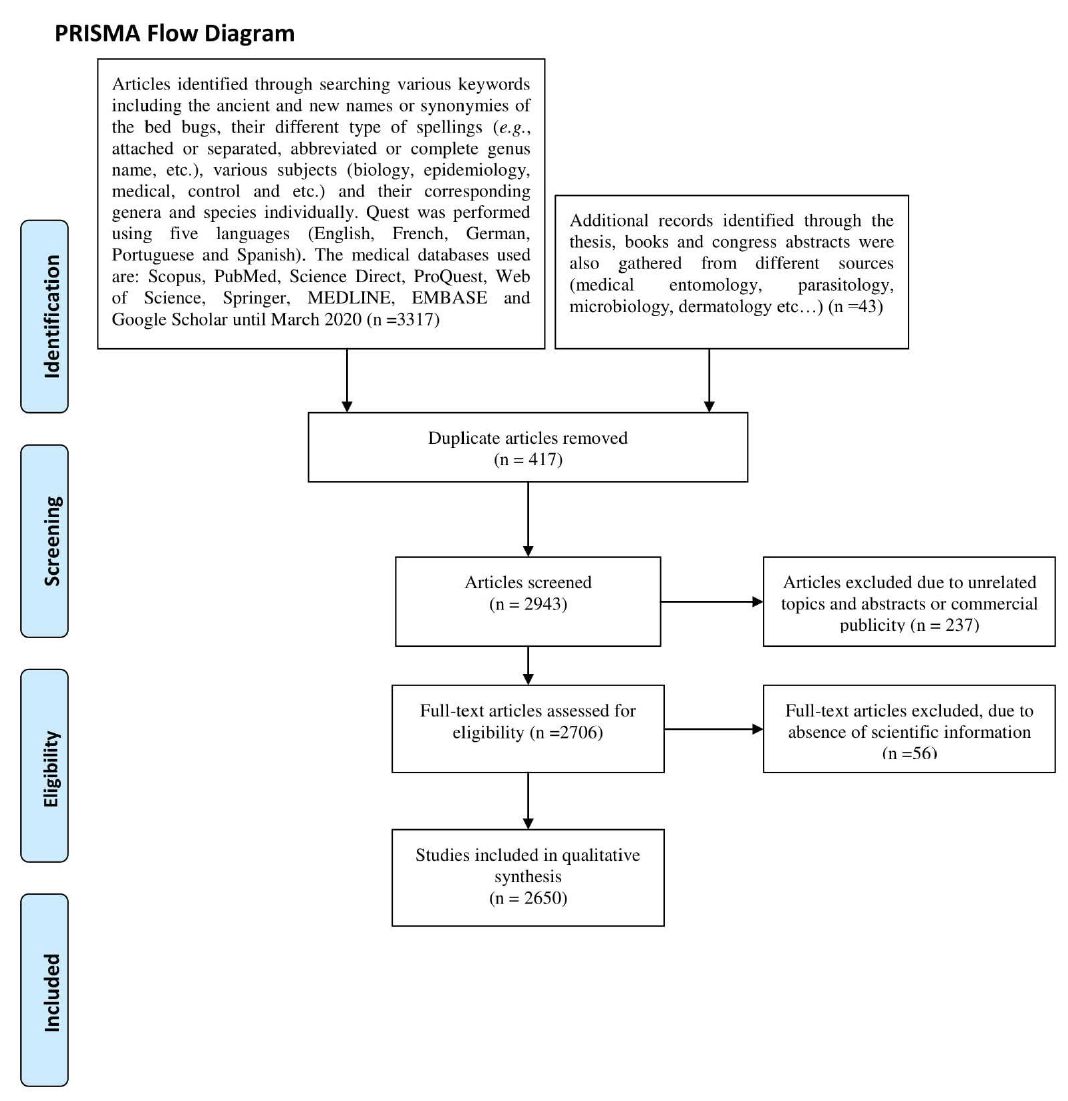
Figure 1. Schematic representation of literature quest strategy used in the present study.